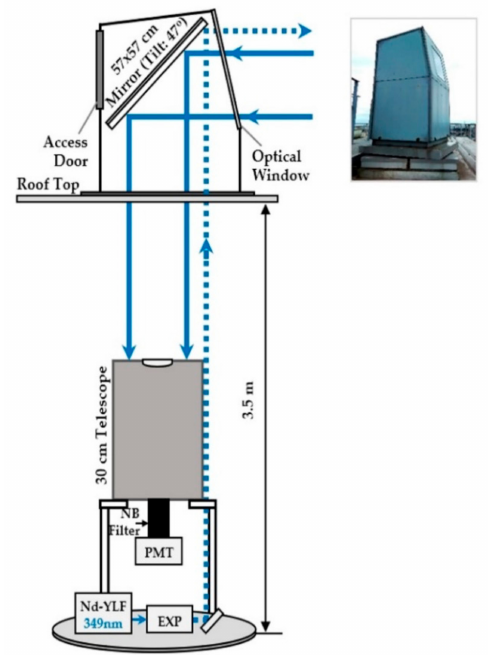
Figure 2. Schematic diagram of the lidar system for observing surface aerosol distribution. It is installed on the rooftop of an eight-story building at an elevation of ~65 m above sea level. An inset picture shows the panel structure with a window used for both transmitting the laser beam and receiving the backscattered